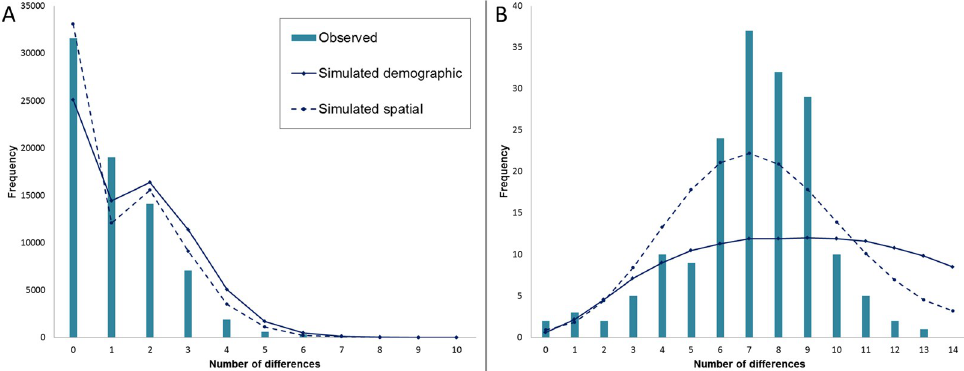
Fig 6. Mismatch distribution of Lucanus cervus mtDNA in lineage I (A) and lineage II (B). The x-axes display the number of nucleotide